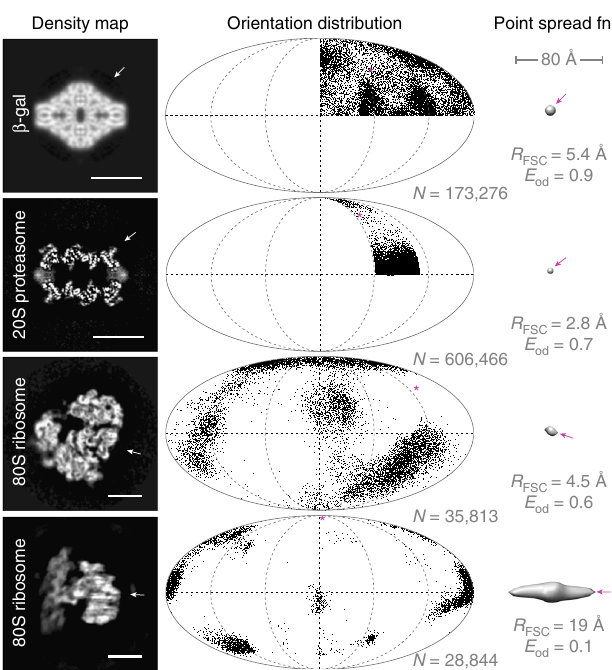
Fig. 2 Assessment of the ef fi ciency of particle orientation distributions in previously published data sets. Each row , from left to right , shows density map of specimen, orientation distribution of particles in the data set, corresponding point spread function and ef fi ciency ( N is the number of asymmetric units, R FSC is the FSC resolution and E od the ef fi ciency). Scale bars are 100 Å. Incomplete orientation sampling causes distortion of the 3D density map, which can be described by the shape of the point spread function. The beta galactosidase and the 20S proteasome data sets have relatively uniform orientation distributions, which bene fi t from the symmetry of the particles, and correspondingly high ef fi ciencies. Their PSFs are close to spherical, meaning that the resolution is isotropic. The two ribosome data sets, where the particles exhibit preferred orientations, have lower ef fi ciencies and yield 3D reconstructions, which are smeared (severely, in the last case) in a particular direction, corresponding to the elongation of the point spread function in that direction. Arrows and stars indicate the direction of minimum